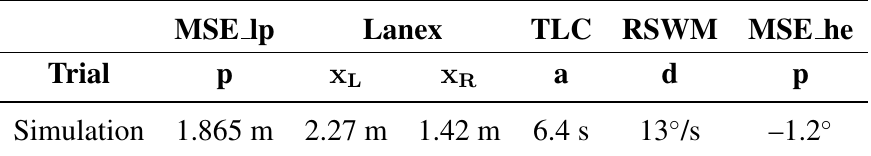
Table 2. Optimized indicators parameters. Lanex, fraction of lane exits; TLC, time to line crossing; RSWM, rapid steering-wheel